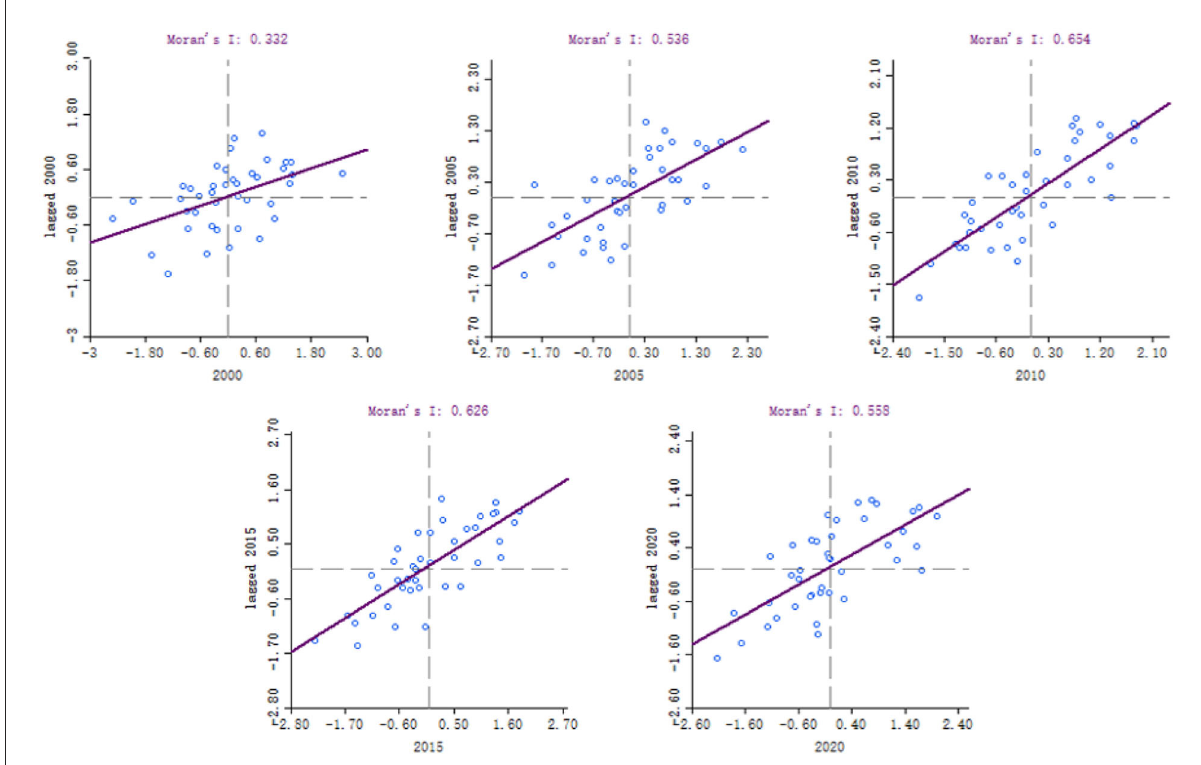
FIGURE4 Moran’s I scatter points in 41 cities of the Yangtze River Delta.